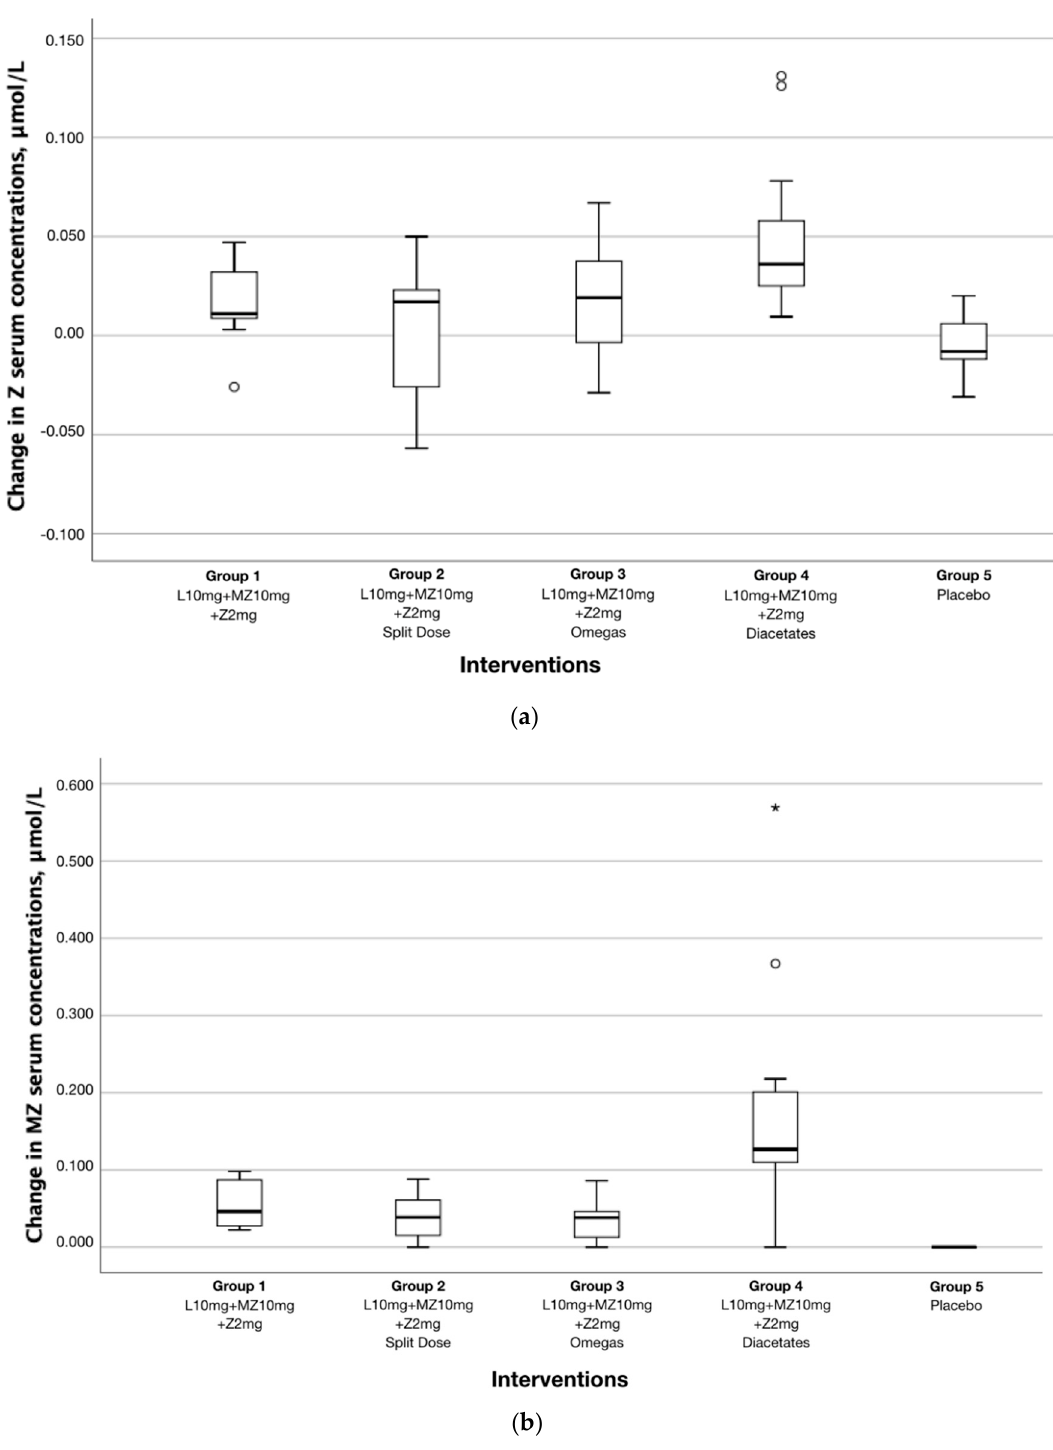
Figure 4. Effect of different formulations in change of serum concentrations. Between-group differences in change in ( a ) Z and ( b ) MZ serum concentrations expressed as change from baseline and 6 months. Z and MZ serum response in Group 4 was significantly higher compared to the other active interventions and placebo ( p < 0.000 to p = 0.019). Outliers are marked with a circle (O) and extreme outliers are marked with an asterisk (*) on the boxplot